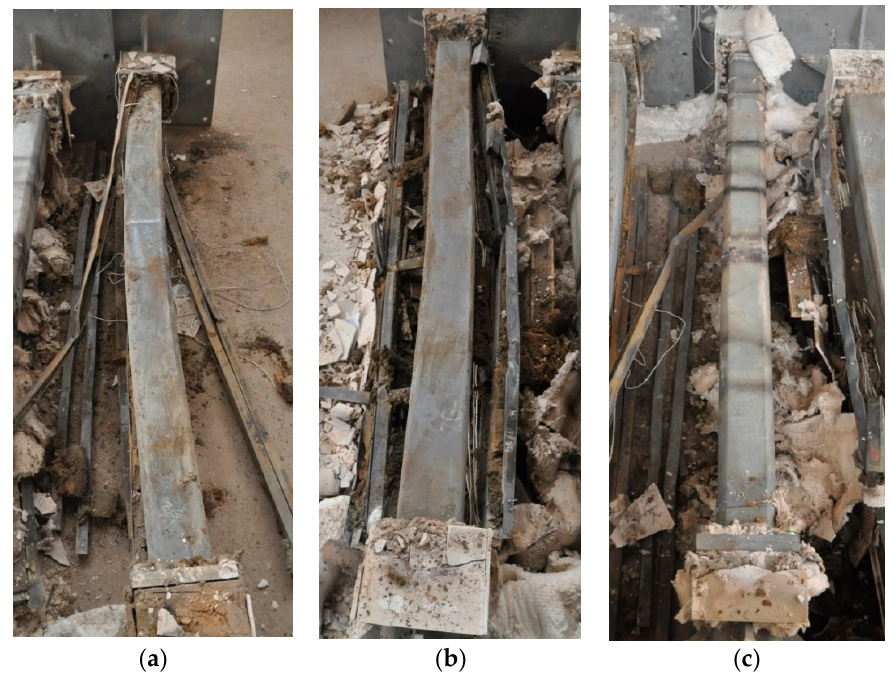
Figure 7. Columns after tests (protections removed): ( a ) HSS-C1; ( b ) HSS-C2; ( c ) HSS-C3. Table 2. Test results of the columns.